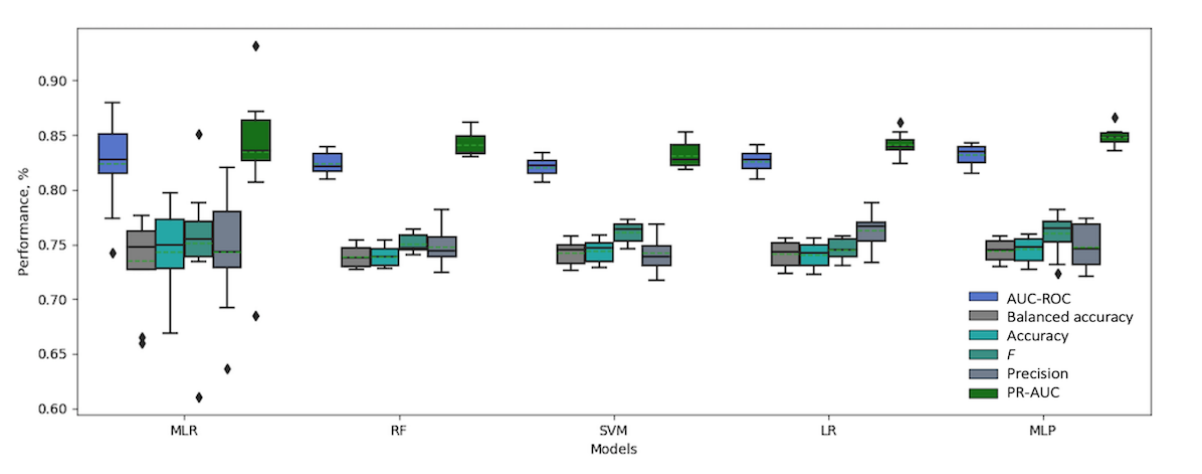
Figure 5. Boxplot showing the detailed 10-fold performance of all models trained with longitudinal data. AUR-ROC: area under the receiver operating characteristic; LR: logistic regression; MLP: multilayer perceptron; MLR: multiple logistic regression; PR-AUC: precision-recall area under the curve; RF: random forest; SVM: support vector